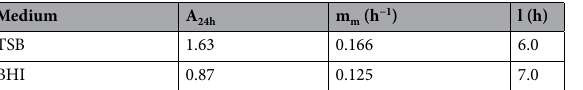
Table 1. Parameters of growth for LM in two media. TSB tryptic soy broth; BHI brain heart infusion; A 24h is the maximum asymptotic value of growth after 24 h of incubation; m m is the maximum specific growth rate of log phase (m m = 1/l). l is the lag time.